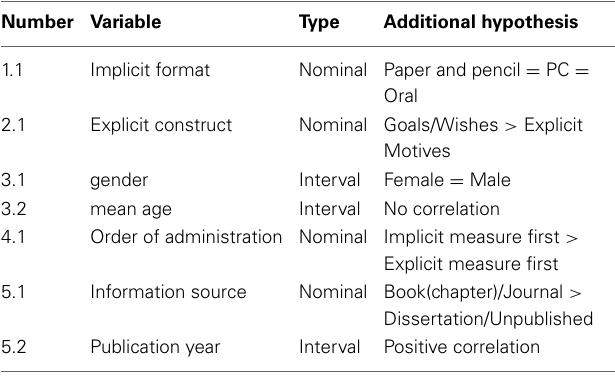
Table 1 | Overview of moderator candidates of the overall relationship of implicit and explicit motive measures investigated in additional